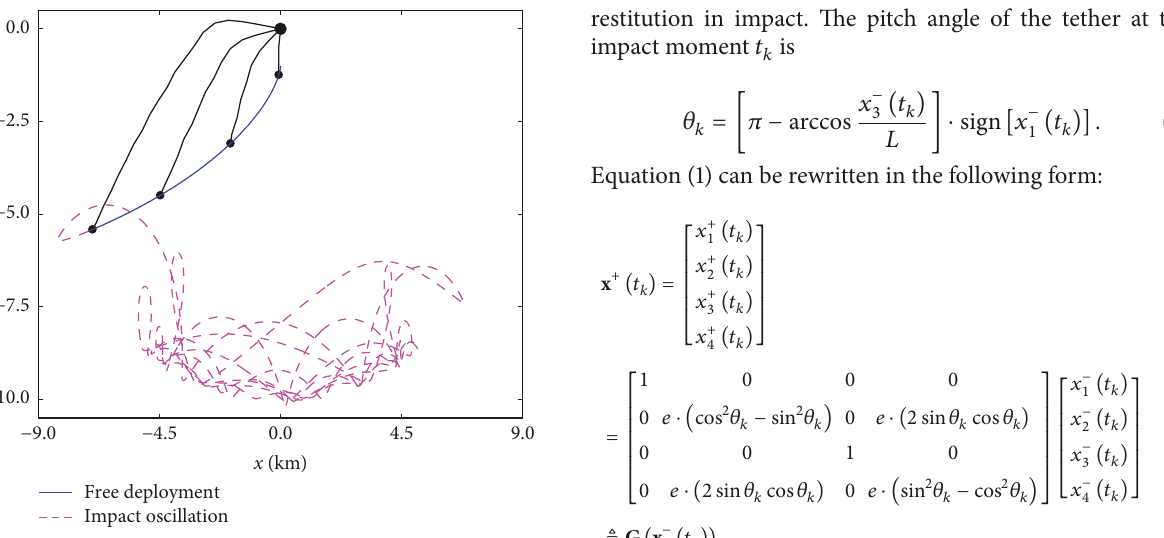
Figure 1: Vibroimpacts of a subsatellite [4].